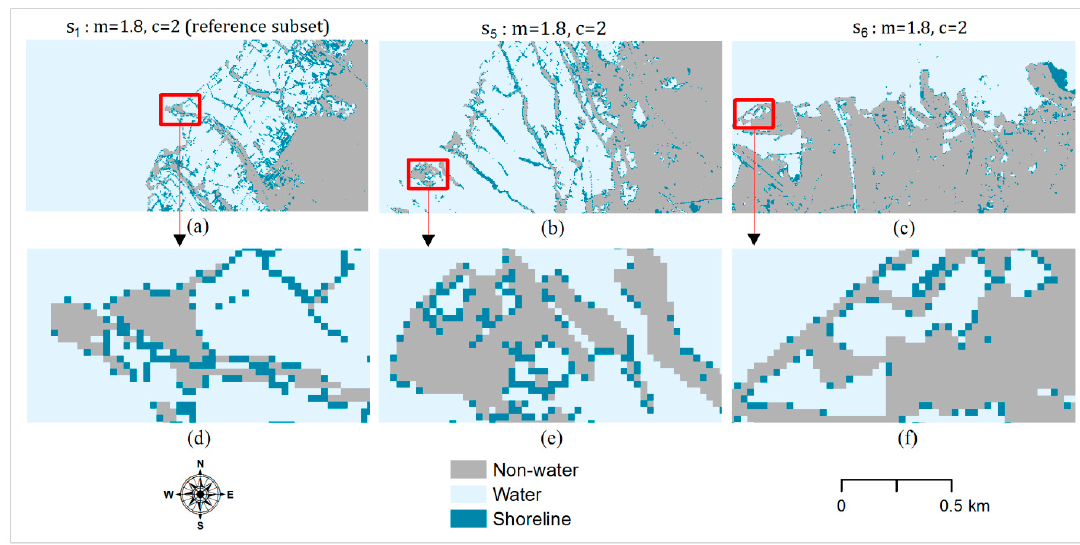
Figure 10. Shoreline margin generated by transferring the shoreline model to target subsets for image I 10 . Subset s 1 ( a ) as the reference subset is used to estimate FCM (fuzzy c -means) parameter at target subsets ( b , c ). We zoom into an area in the red rectangle site ( d – f ) to see a variation of shoreline margin.